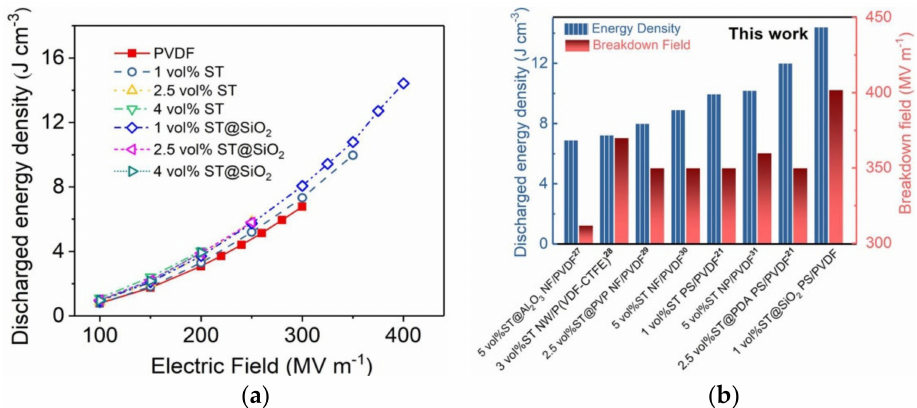
Figure 7. ( a ) Discharged energy density at varied electric fields of PVDF and composites as a function of platelets content measured at varied electric fields and ( b ) comparison of energy density and breakdown field between this contribution and previously reported references.